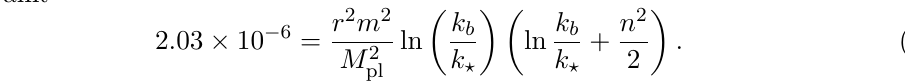
Figure 12 . The prediction for the characteristic suppression scale as a function of the initial values of the (cid:12)elds. The mapped regions should be interpreted not as having hard boundaries, but rather fuzzy endpoints where they break down. Here we have used T reheat = 10 MeV and r = 2 n . deviation from single-(cid:12)eld in(cid:13)ation would be seen at this scale), the spectrum of [53]